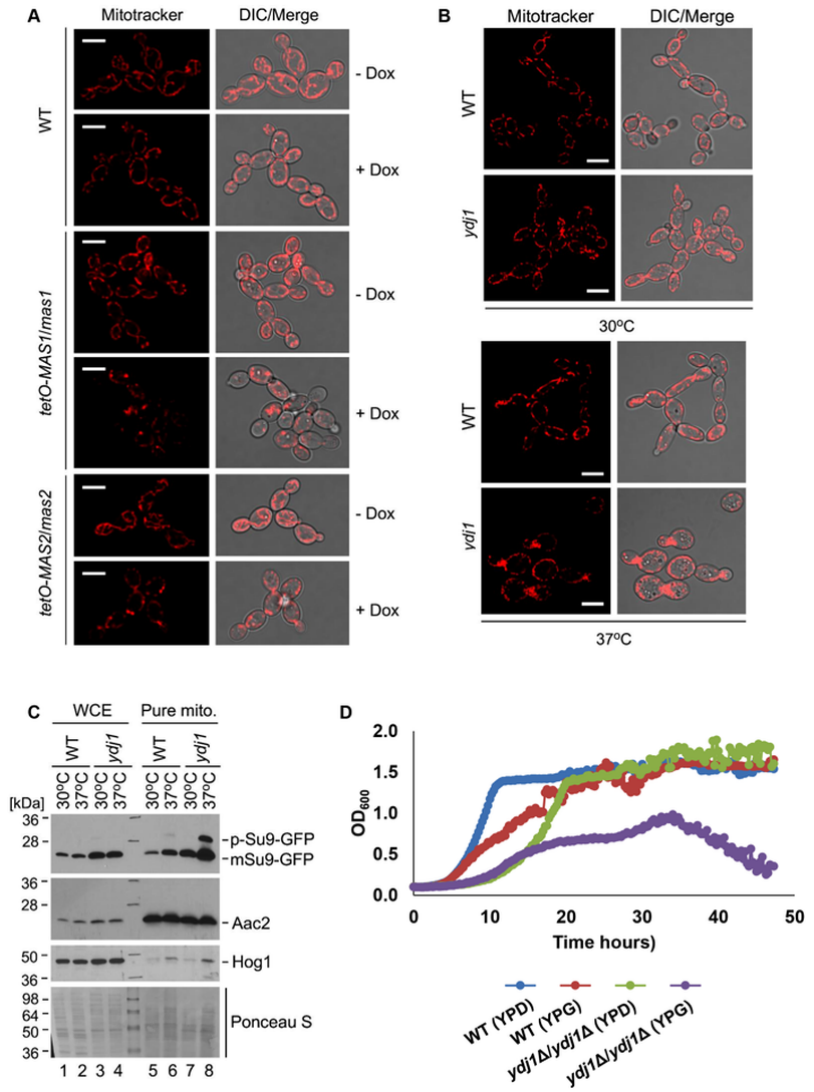
FIGURE 7: Mas1, Mas2 and Ydj1 are im- portant for mitochondrial morphology and function. (A) The wild-type, tetO- MAS1/mas1 Δ and tetO-MAS2/mas2 Δ strains were grown in YPD in the absence (- Dox) or presence (+ Dox) of 20 μg/mL doxycycline for 24 hours, and then subcul- tured in the same conditions for an addi- tional 4 hours to deplete MAS1 and MAS2 . Cells were stained with MitoTracker Red dye (mitochondria) for one hour, and ex- amined by confocal microscopy. Repre- sentative images are shown. Scale bar indicates 5 μm. (B) Ydj1 is required for normal mitochondrial morphology at high temperatures. The ydj1 Δ/ ydj1 Δ mutant was grown in YPD for 16 hours at 30 (cid:176) C, and then diluted 10 times in fresh YPD medium and grown for a further 6 hours at 30 (cid:176) C or 37 (cid:176) C. Samples were stained with 100 nM MitoTracker Red for 1 hour and examined by confocal microscopy. Repre- sentative images are shown. The scale bars indicate 5 μm. (C) Ydj1 is required for im- port of the artificial substrate Su9-GFP under elevated temperatures. Whole cell extract (WCE) and gradient-purified mito- chondria were obtained from wild-type and ydj1 Δ/ ydj1 Δ cells harboring